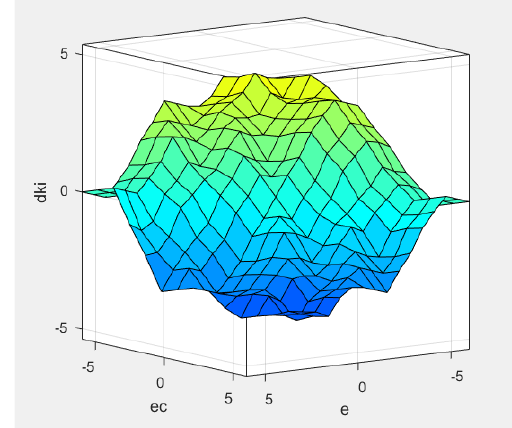
Figure 4. output surface. Figure 4. ∆ k i output